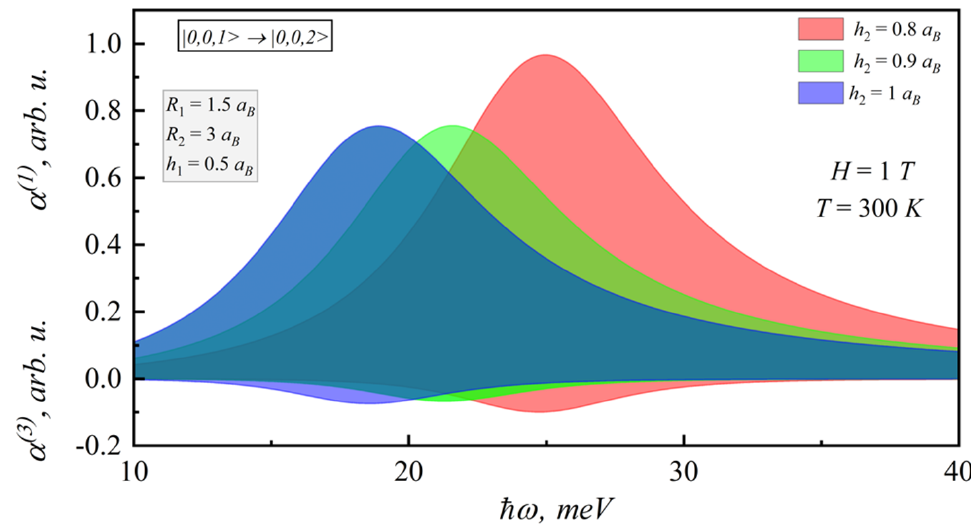
Figure 8. Spectral dependences of the linear and nonlinear intraband absorption coefficients on pho- ton energy for different lens-shaped QD heights.